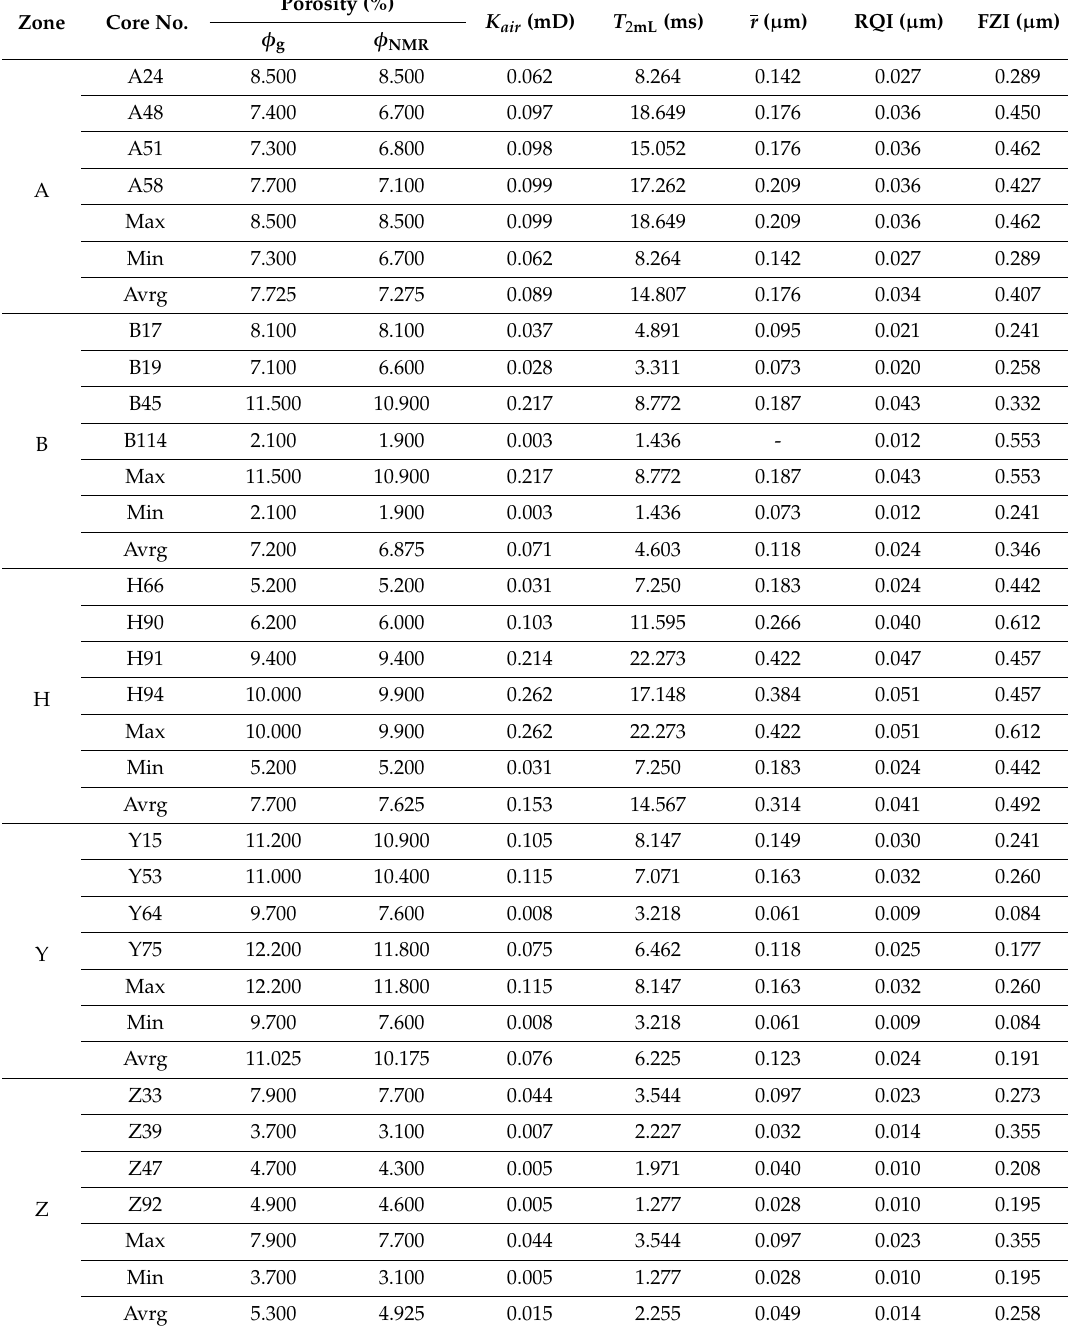
Table 1. Parameters of the core